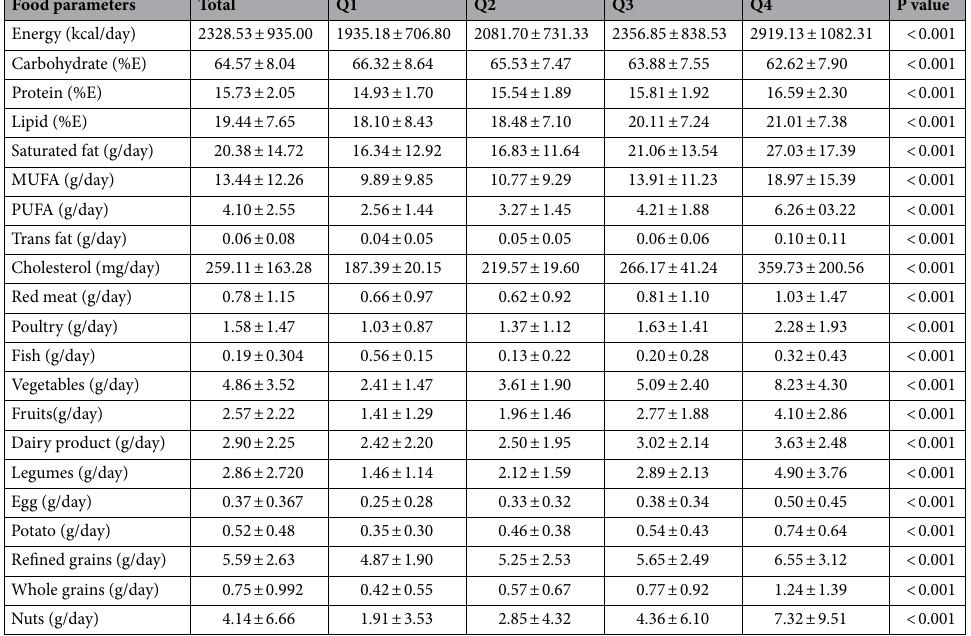
Table 2. Description of food parameters participants according to the dietary inflammatory index score.